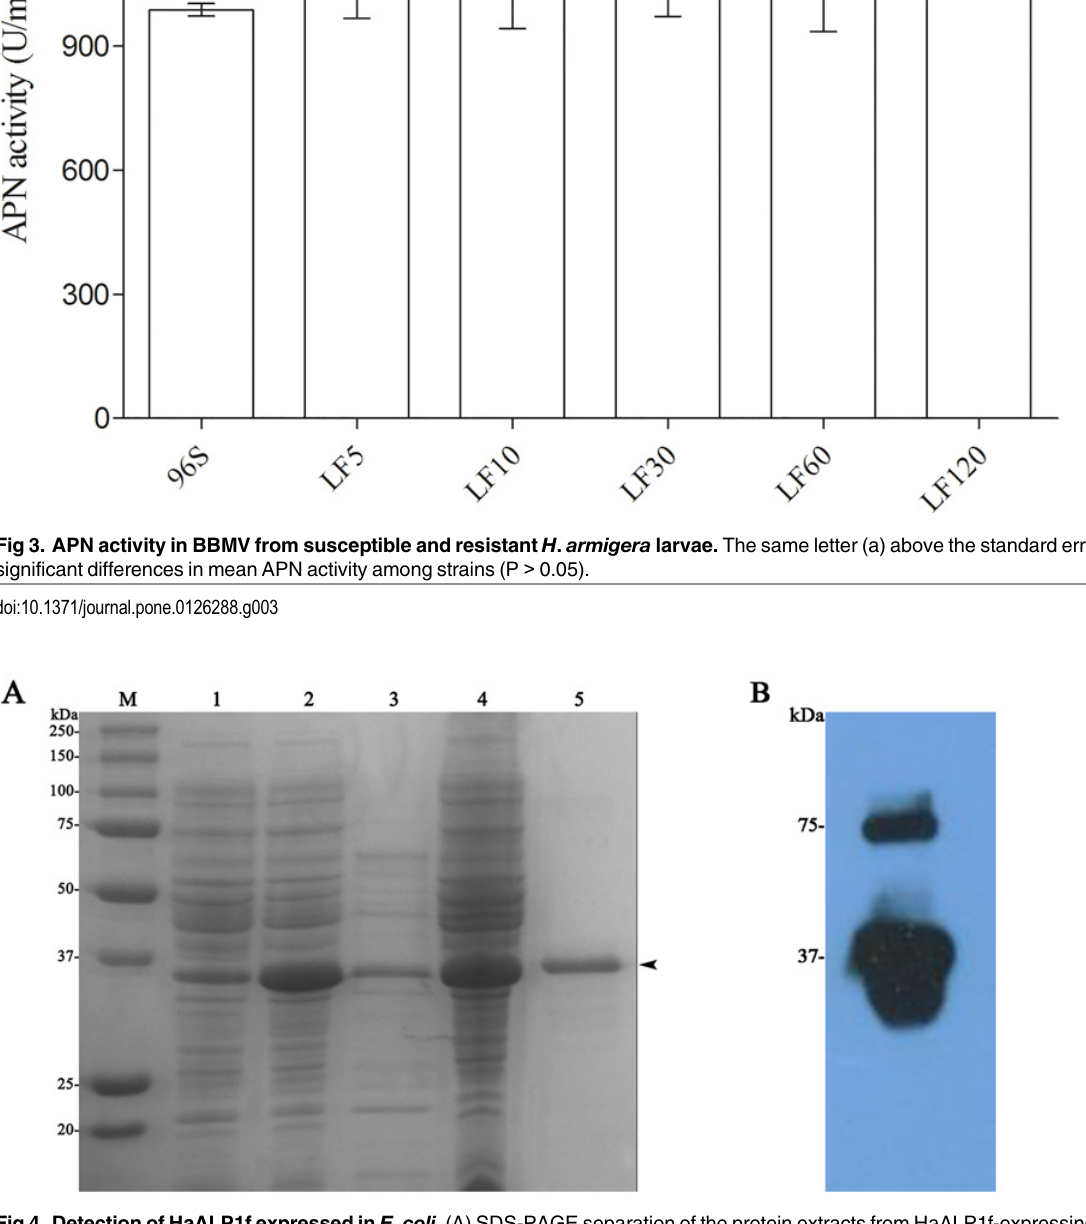
PLOS ONE | DOI:10.1371/journal.pone.0126288 April 17,